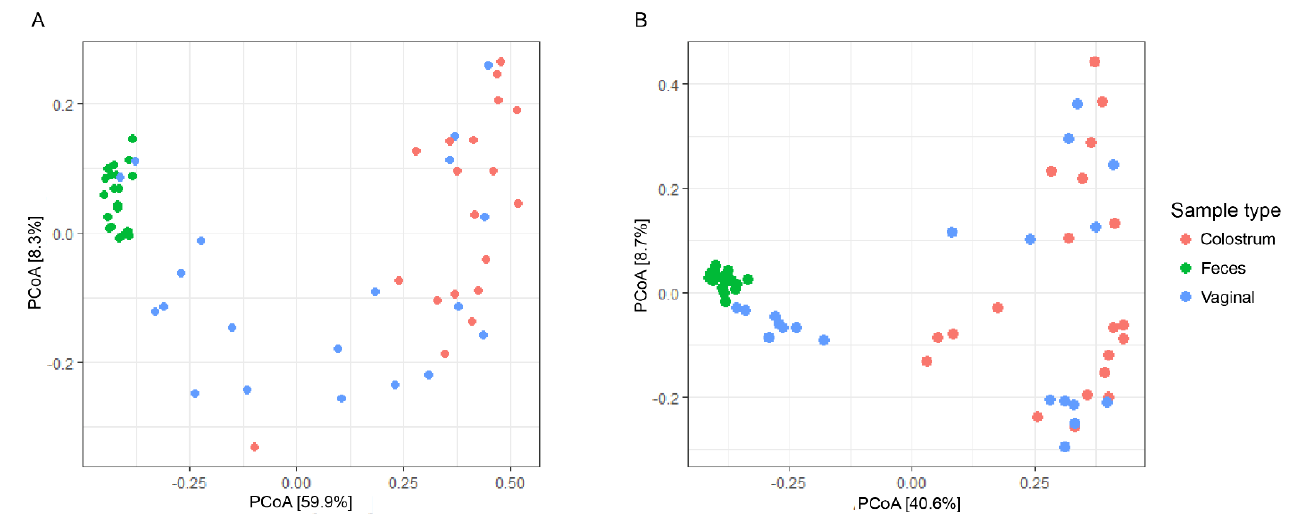
Figure 3. A summary of the global microbiome analysis of the samples from the 20 Holstein cows taken immediately after calving are displayed using weighted ( A ) and unweighted ( B ) UniFrac metric calculations to plot distances. The mucosal source of the samples is indicated by the color of the marker.